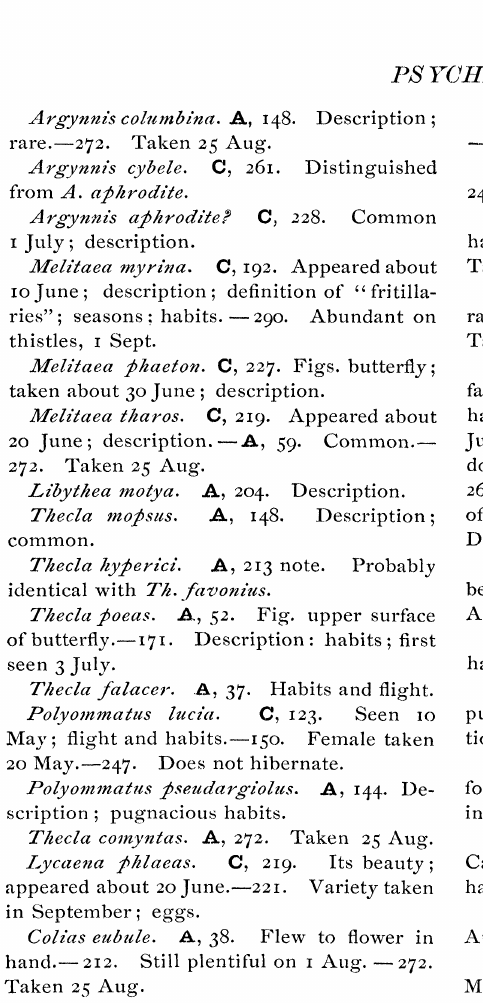
pupa and under surface of imago; descrip- tion.--I48. Nearly all gone July. Pajbilio asterius.